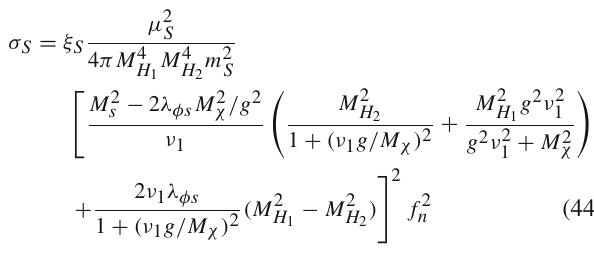
a combined analysis, direct detection and relic density in Fig. 7. In order to study the effect of the direct detection experiment on the model, the rescaled DM–nucleon cross section ξ χ σ χ and ξ S σ S should be considered. Scatter points in Fig. 7 (left) show the allowed region in parameter space of the model in the M s and M χ plane for different parameters of the model which are consistent with the observed relic density by the Planck collaboration [38]. In these figures, it is supposed that 0 . 11 < (cid:13) h 2 < 0 . 13 for the allowed range of relic density and also 0 < λ φ s < 3, and 0 . 5 < g < 1 . 5. The right figures depict the rescaled DM–nucleon cross section versus DM mass for different values of the other model parameters. The solid line determines the upper limit of the LUX experiments [40] for the direct detection of DM and the dashed line shows the regions of parameter space which are expected to be probed by the future direct detection experiment XENONnT